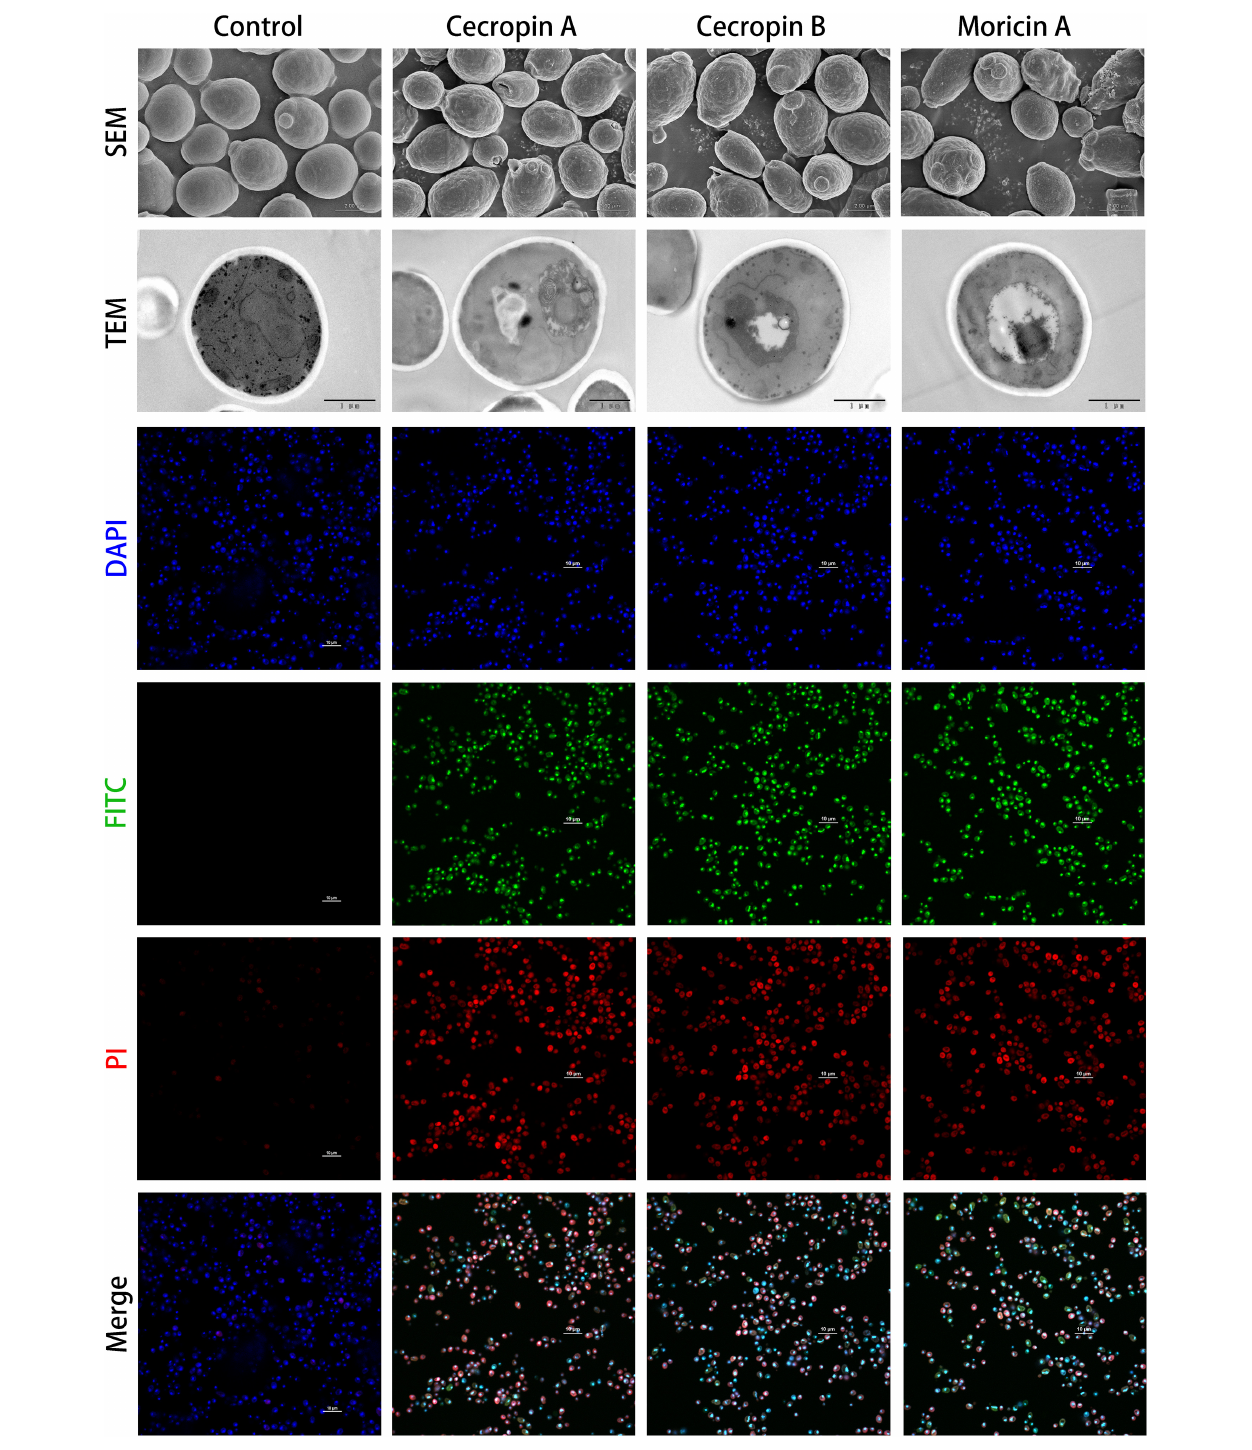
FIGURE 6 | Microscopic investigation of antifungal capabilities of designed antimicrobial peptides (AMPs). The antifungal effects of cecropins and moricins, which had been confirmed by microtiter broth dilution assays ( Table 3 ), were analyzed by combination of scanning electron microscopy (SEM; first upper panel), transmission electron microscopy (TEM; second upper panel), and confocal fluorescence microscopies (lower panels). Although there were no apparent morphological changes observed by electron microscopies, the confocal microscopy demonstrated the fluorescein isothiocyanate (FITC) (green) labeled peptides colocalized with DAPI (blue)-stained fungus nucleus, and the FITC fluorophore showed high spatial overlaps with propidium iodide (PI) (red) fluorescence, which indicates a probable cell death induction mechanism caused by DNA binding.